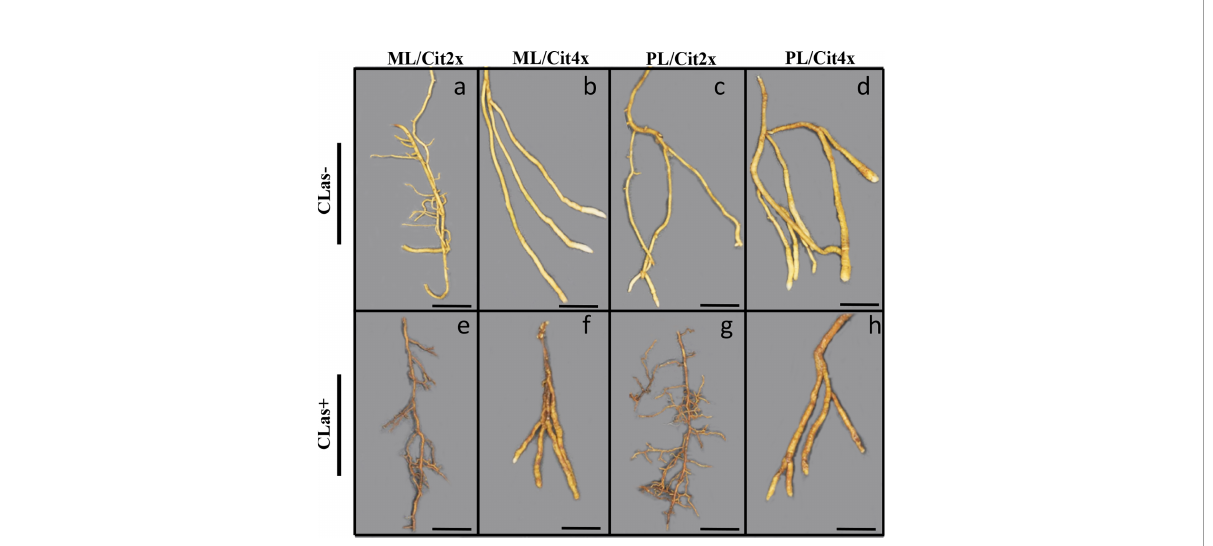
FIGURE 1 Macroscopic pictures of 2x (A, C, E, G) and 4x (B, D, F, H) Swingle citrumelo rootstocks secondary roots in control (CLas-) and HLB infected (CLas+) trees. ML and PL mean Mexican lime ad Persian lime. Cit2x and Cit4x mean 2x Swingle citrumelo and 4x Swingle citrumelo. Bars = 1